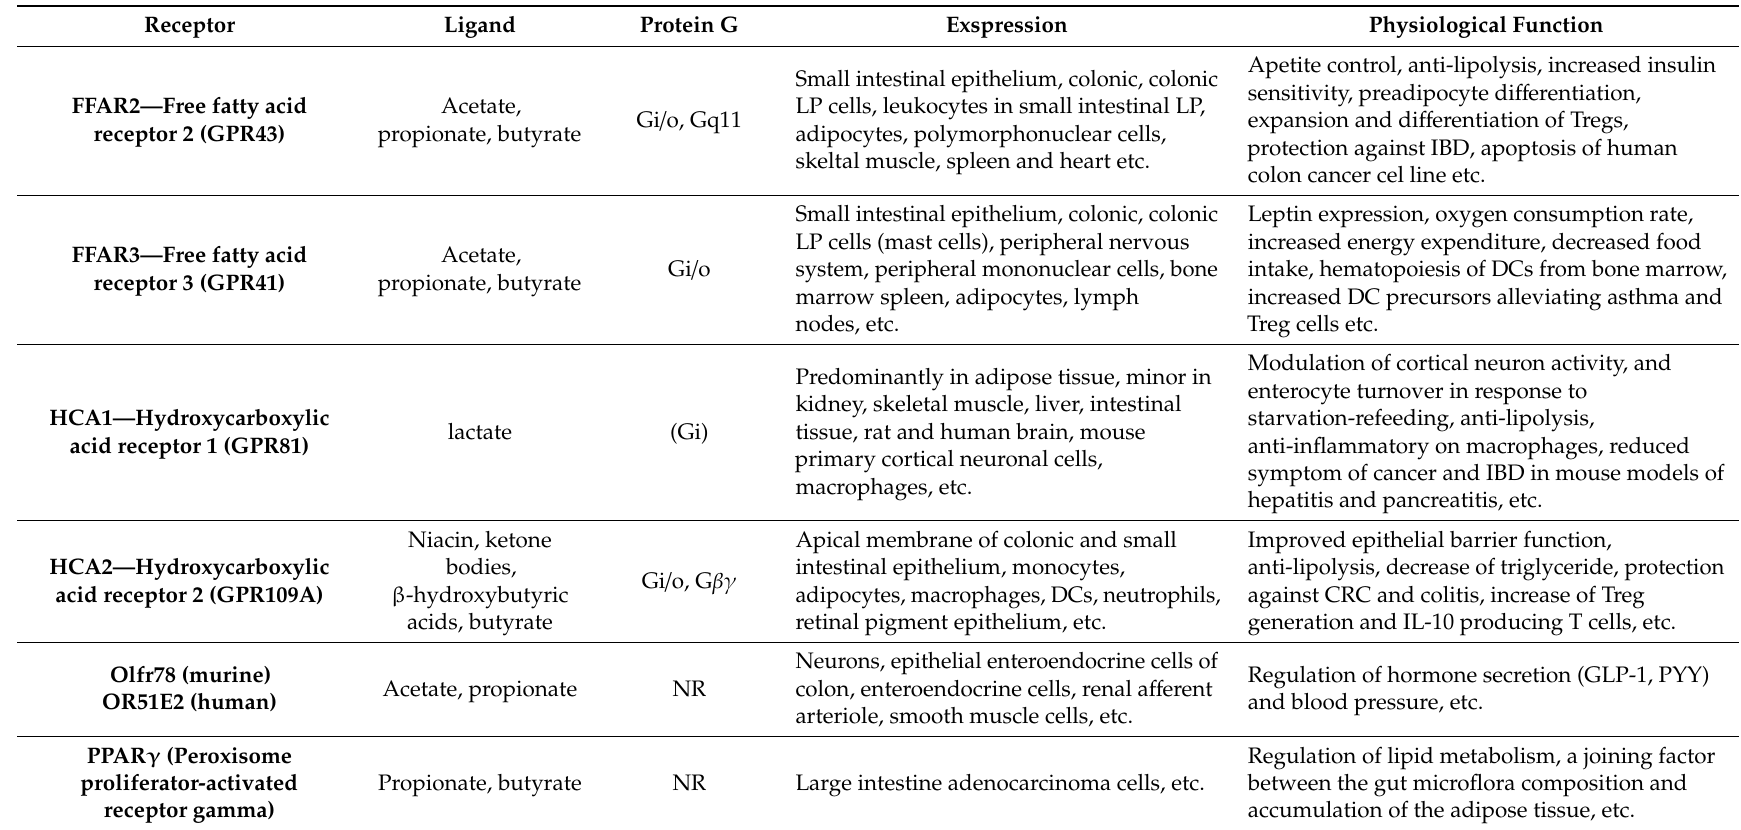
Table 3. The characteristics of SCFAs and lactic acid receptors